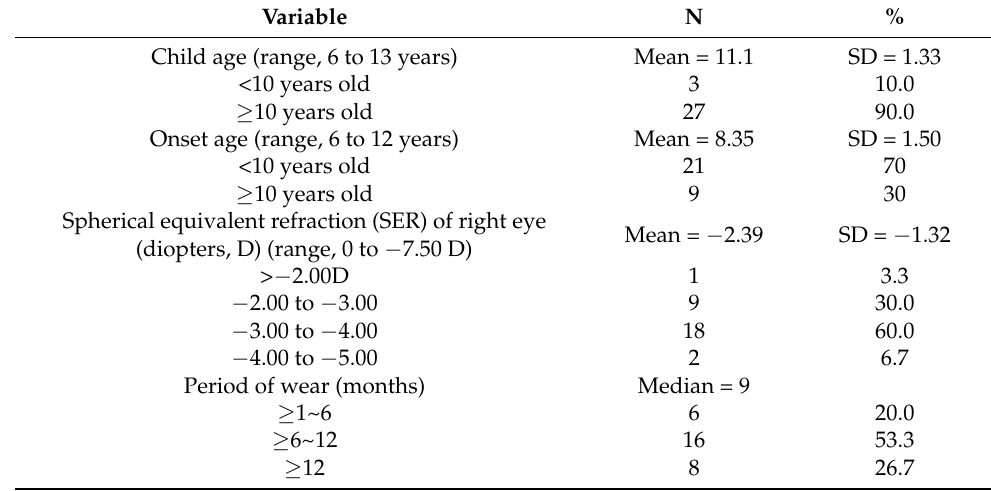
Table 4. Demographic information of myopic children.